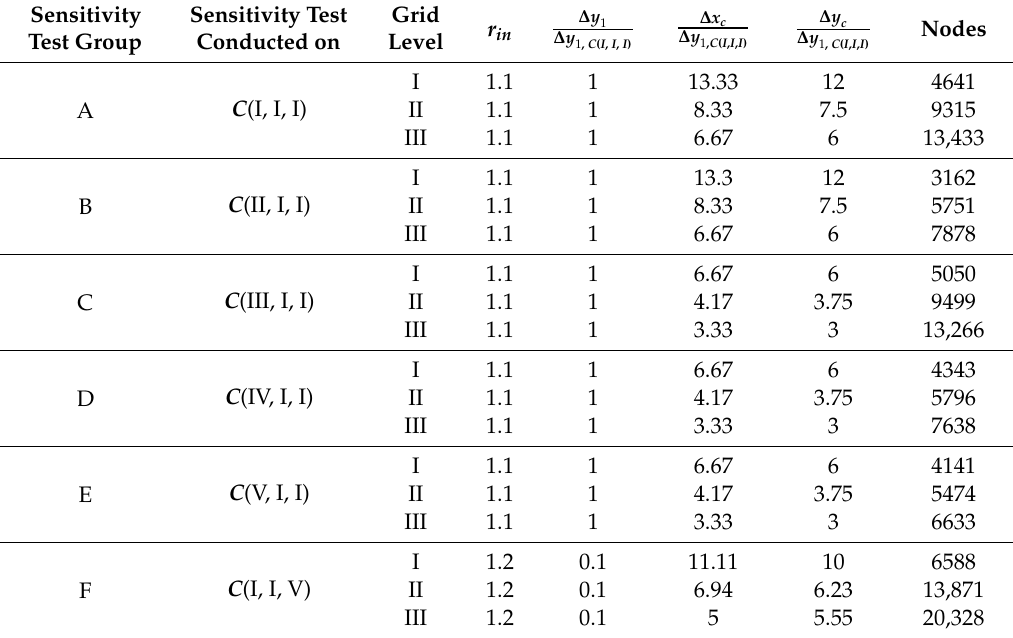
Table 3. Details of grid sensitivity